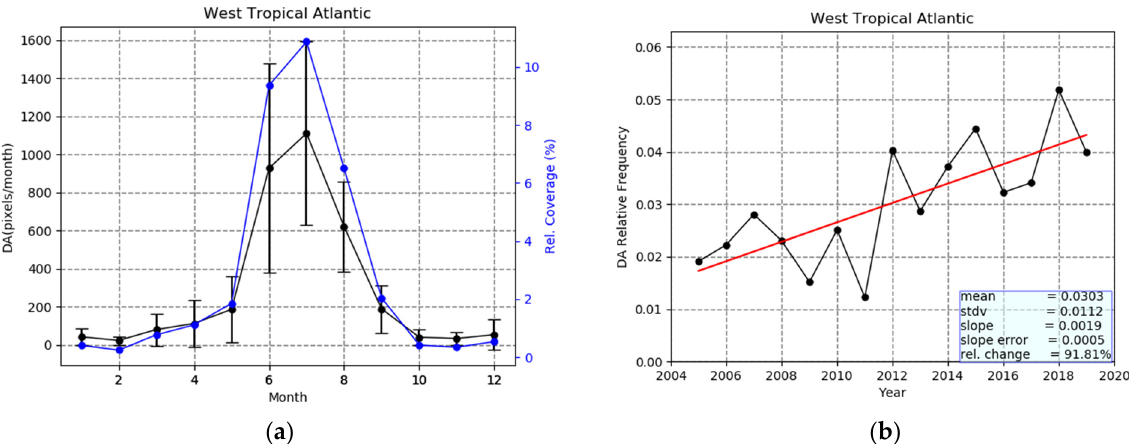
Figure 10. ( a ) Intra-annual variability of the 2005–2019 averages of the total absolute number of grid cells (1° × 1°), where dust aerosols (DA) were detected over West Tropical Atlantic by the satellite algorithm (left axis) and the percent coverage of the region by dusty grid cells (right axis). The error bars represent the year-by-year variability by means of computed 2005–2019 standard deviations. ( b ) Inter-annual variability and linear trend of the relative frequency of dust aerosols (DA) over West Tropical Atlantic.